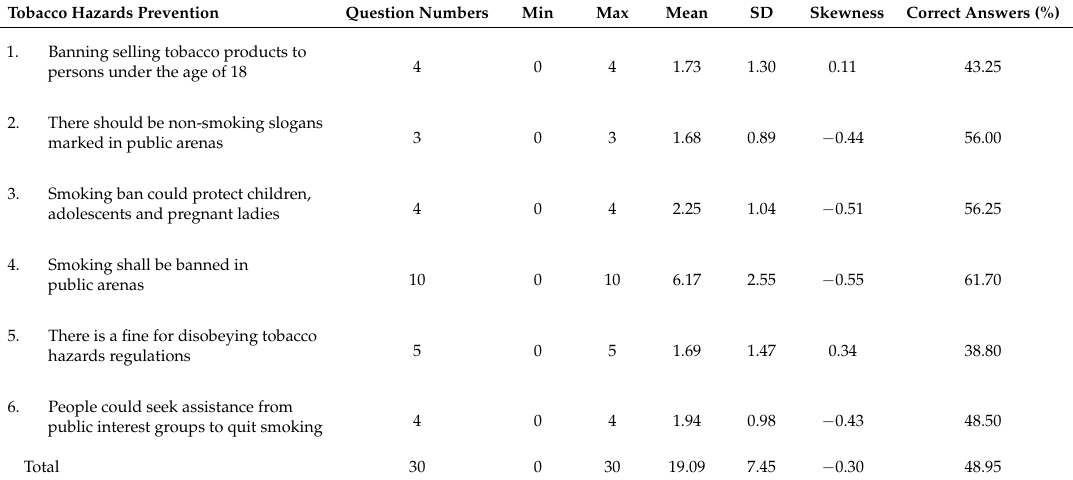
Table 4. Degree of understanding of tobacco hazards prevention (n = 534).